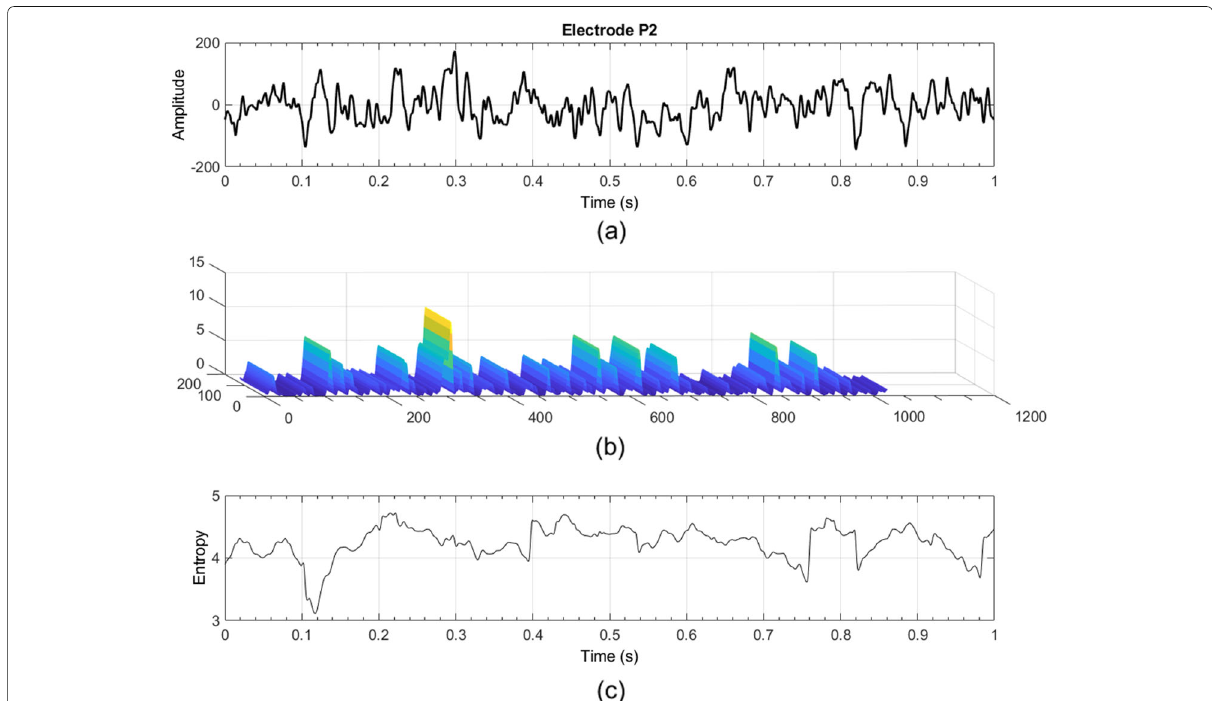
Fig. 9 Electrode P2. a Time domain representation of ERP. b SPWVD time-frequency representation. c Short-term Rényi entropy of the distribution